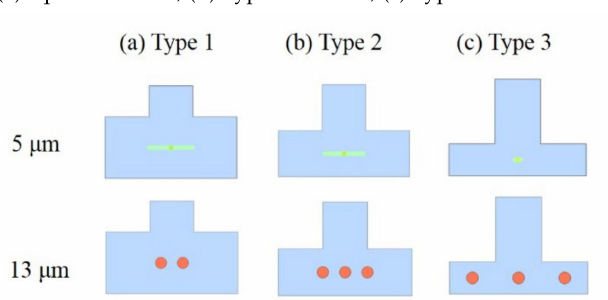
Figure 7. Positions of 5 µ m and 13 µ m particles distributed within the channel for the flow rate of 100 µ L/min. ( a ) Type 1 channel, ( b ) Type 2 channel and ( c ) Type 3